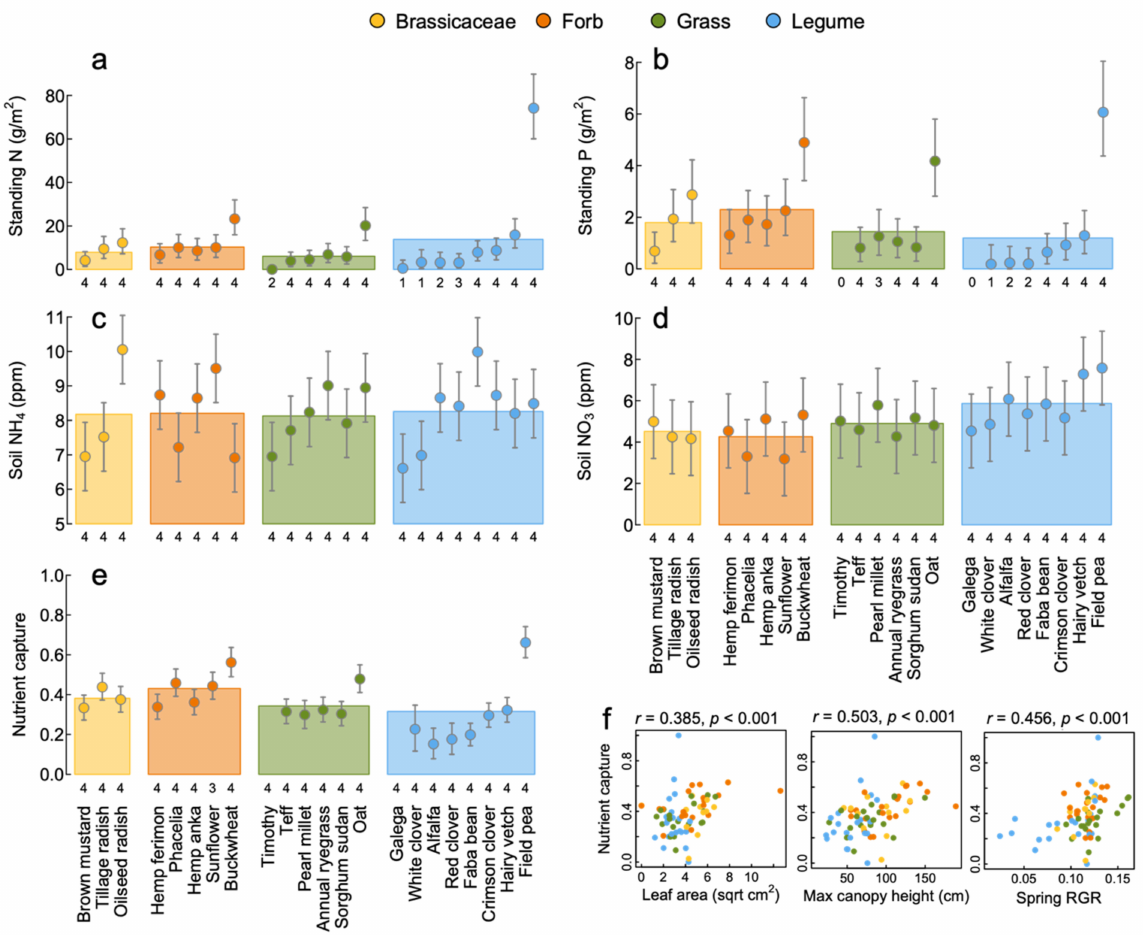
Figure 2. Nutrient capture. Crop standing N ( a ) and P ( b ) and the concentration of soil ammonium ( c ) and nitrate ( d ) remaining in the soil at the time of harvest are shown. Greater standing N and P and reduced soil ammonium and nitrate levels at harvest indicate greater nutrient capture of the crop ( e ). Points show means, and error bars are model estimates of standard errors for comparison among means of the crops. Numbers below each mean are the number of replicates included. Note that for the standing N and P, replicates are low due to the lack of enough plant material for analyzing plant N and P content. The colored bars show overall means for each plant functional group (indicated by the different colors). Statistics are provided in Table 3. Significant correlations (Spearman) between nutrient capture and crop functional traits are shown in ( f ). Nutrient capture was unrelated to leaf mass per area or rooting density ( r = 0.103, p = 0.379 and r = 0.184, p = 0.113